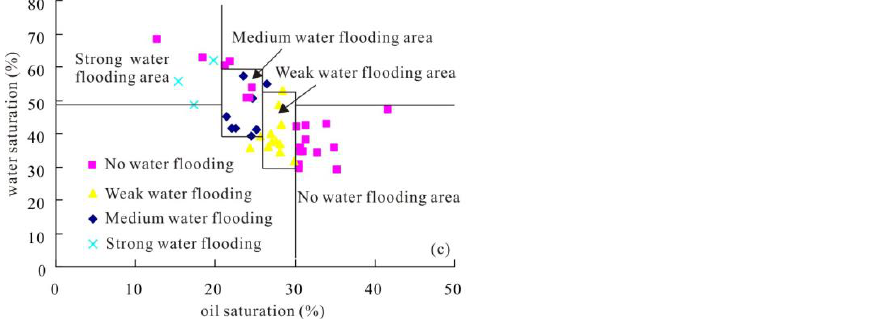
Figure 5. Identification cross-plot of water-flooding degrees by different facies of E 2 s 14 – 7 in the Zhenwu area, Gaoyou Sag: ( a ) delta facies; ( b ) braided fluvial facies; ( c ) meandering fluvial facies. Table 1. Discernment criterion of water-flooding degrees of E 2 s 14 – 7 in the Zhenwu area, Gaoyou Sag.